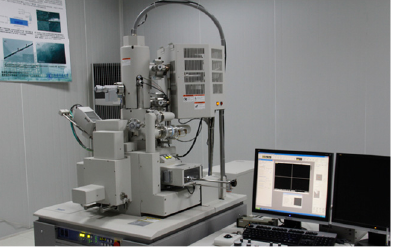
Figure 4. HITACHI SU8010 scanning electron microscope.